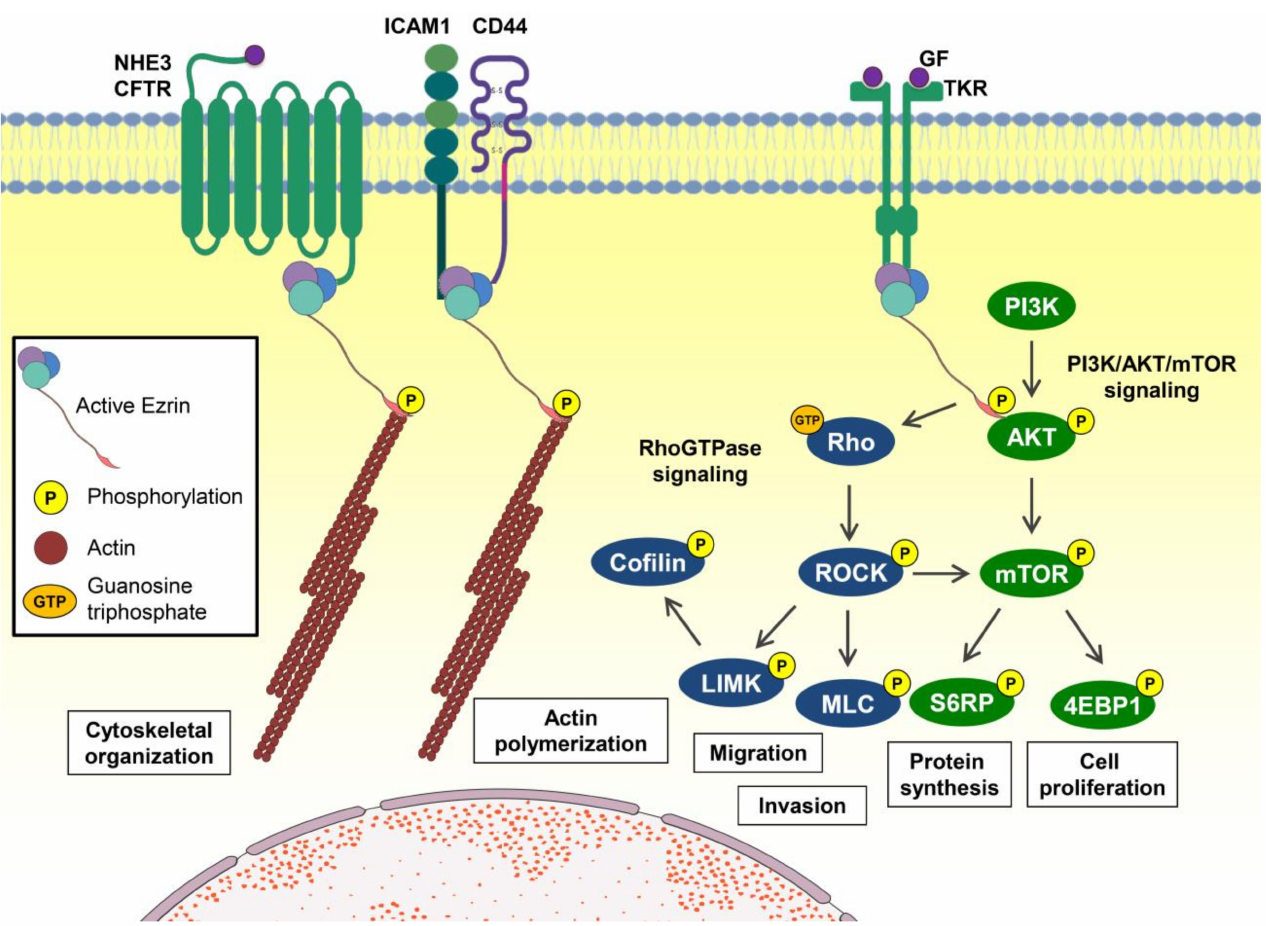
Figure 1. Ezrin-mediated signaling pathways and cellular processes. When phosphorylated, ezrin (EZR) may bind membrane proteins such as G protein-coupled receptors (GPCRs) and other receptors allowing the binding of F-actin (actin filaments) with the membrane, promoting reorganization of the cytoskeleton. EZR also binds to several transmembrane receptors, such as growth factor or cytokine receptors, promoting the activation of multiple signaling pathways. Among the main signaling pathways triggered by EZR, we highlight the PI3K/AKT/mTOR pathway, which promotes protein synthesis and cell proliferation, and the Rho GTPase pathway, which promotes migration, invasion, and actin polymerization. Abbreviations: NHE3, Na+/H+ exchanger; CFTR, cystic fibrosis transmem- brane conductance regulator; ICAM1, intercellular adhesion molecule 1; CD44, cell surface adhesion receptor; GF, growth factor; TKR, tyrosine kinase receptor; P, phosphorylation; GTP, guanosine triphosphate; PI3K, phosphatidylinositol 3-kinase; AKT, protein kinase B; mTOR, mammalian target of rapamycin; S6RP, ribosomal protein S6; 4EBP1, eukaryotic initiation factor 4E-binding protein 1; Rho, homologous Ras proteins; ROCK, Rho kinase; MLC, myosin light chain; LIMK, LIM kinase. The EZR C-terminal domain, especially 34 amino acid residues, is highly conserved among ERM proteins and binds to the actin cytoskeleton. A coiled-coil structure connects the N-terminal FERM domain and the C-terminal actin-binding domain. The primary protein structure of EZR and its inactive and active conformations are illustrated in Figure